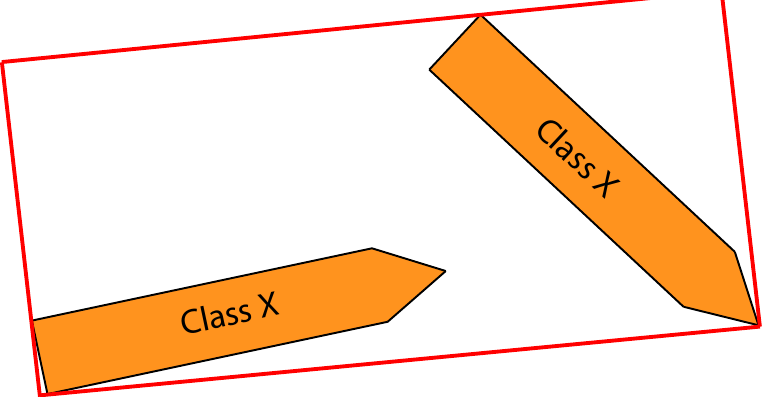
Figure 6. Rotated bounding box encompassing two instances of the same